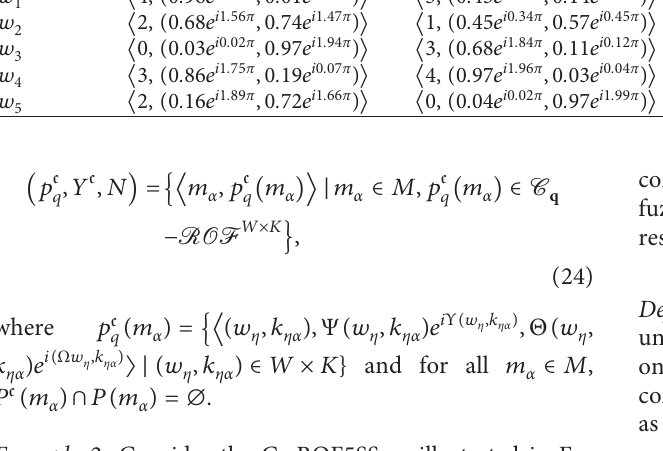
Table 5: Tabular representation of C